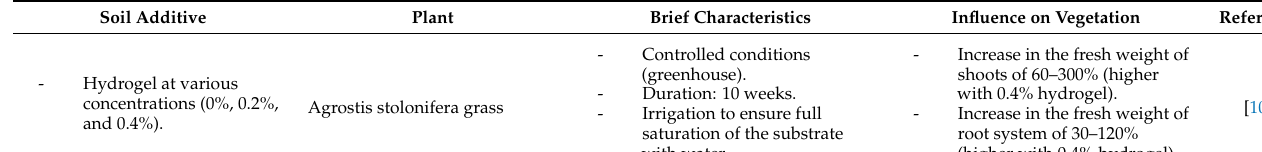
Table 2. Comparison of the influence of soil additives on plant